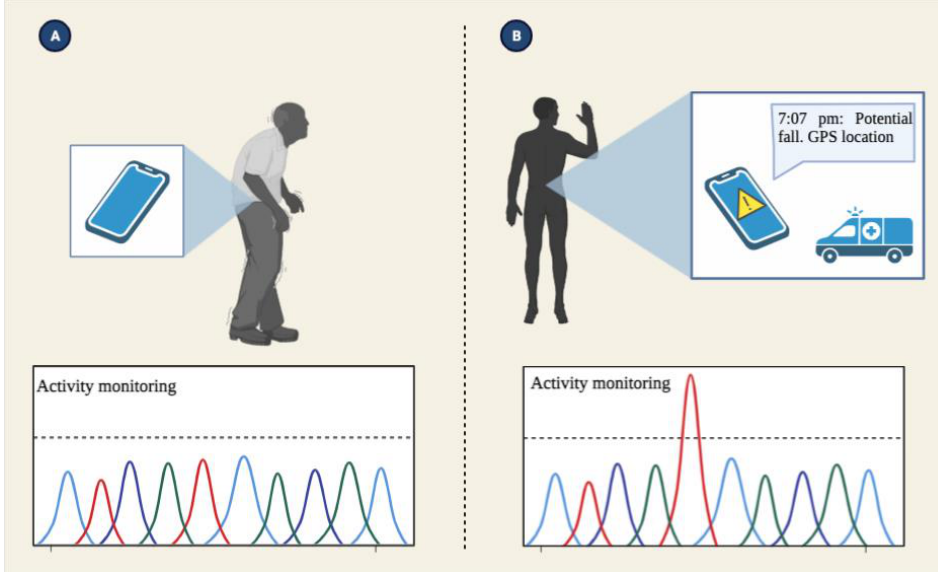
Figure 5. Data processing. Based on specific parameters and with the help of algorithms fed by the SP sensors, researchers can predict the risk of a patient falling. ( A ) Sensors in SP, such as accelerometers, gyroscopes, and magnometers, monitor the patient's daily activities. ( B ) Once a measurement exceeds the threshold previously stablished, the SP collects and processes sensors data before responding to a potential fall event by alerting emergency personnel and caregivers.